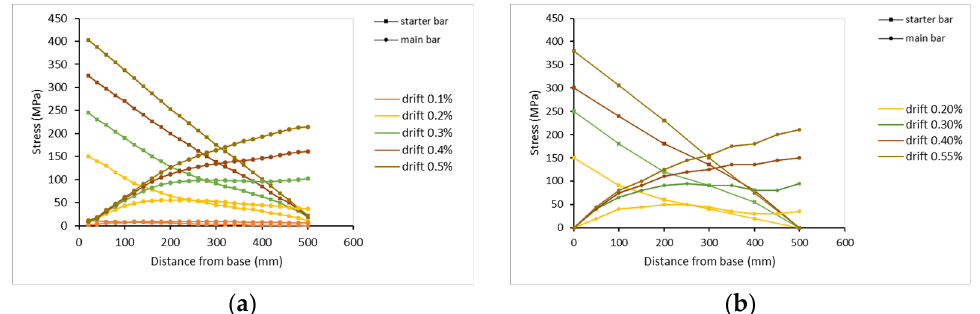
Figure 10. Predicted steel stress distribution on starter and main bar, for ( a ) monotonic analysis, and ( b ) cyclic analysis (based on results by [108]).